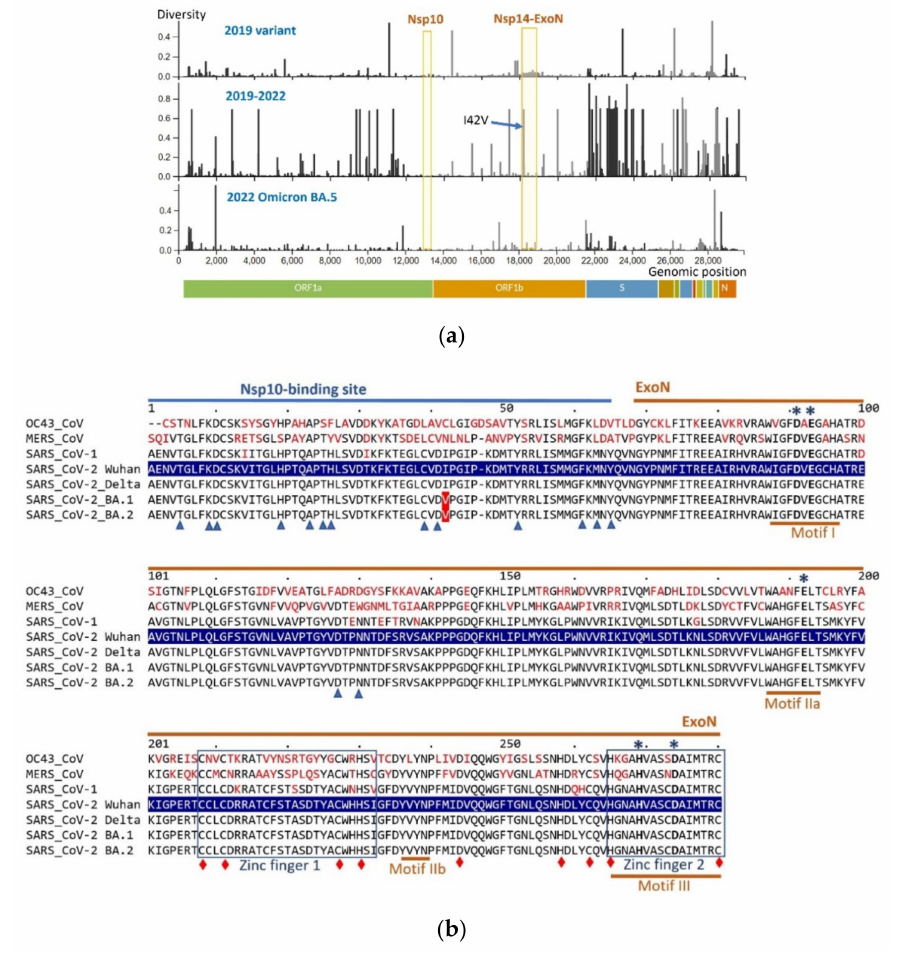
Figure 1. ( a ) Diversity of the encoded amino acids along genomic sequences of SARS-CoV-2. Profiles for three genomic sets are shown— top: diversity within ~2000 genomic sequences of the early SARS-CoV-2 sampled between December 2019 and March 2020; middle: diversity within ~2000 genomes collected in December 2019–May 2022; bottom: diversity within ~900 genomes of the recent Omicron BA.5 variant collected from January–May of 2022. The Nsp14-ExoN boundaries include only the first 280 aa positions involved in ExoN function (the same region shown in the sequence alignment). The arrow points to the position of the ubiquitous I42V aa substitution in Nsp14. Profiles are constructed by the Nextstrain webtool using genomic sequences from GISAID (https://www.gisaid.org/; Nextstrain datasets: “early-19A” and “22B Omicron”; webtool accessed on 25 May 2022 at https://nextstrain.org [61]). ( b ) Protein sequence conservation in the ExoN domain of Nsp14 in representative beta Coronaviridae strains. Partial Nsp14 protein alignment spans the Nsp10-binding site (amino acid positions 1–64) and the adjacent ExoN domain (aa positions 68–280). Nsp14 of the SARS-CoV-2 Wuhan-Hu-1 variant (highlighted in blue) was used as a reference: amino acid differences in other variants compared to the reference sequence are shown in red. Functional motifs comprising the ExoN active site are underlined, and the zinc finger regions are boxed [12,14,36]. ExoN catalytic residues are indicated with asterisks; residues interacting with Nsp10 are marked by blue triangles; and positions critical for zinc fingers, protein solubility or ExoN activity are shown as red diamonds [12,14]. The sequences were retrieved from GenBank: OC43-CoV (common cold; accession number YP_009924328), MERS-CoV (YP_009047225), SARS-CoV-1 (JX163928), and variants